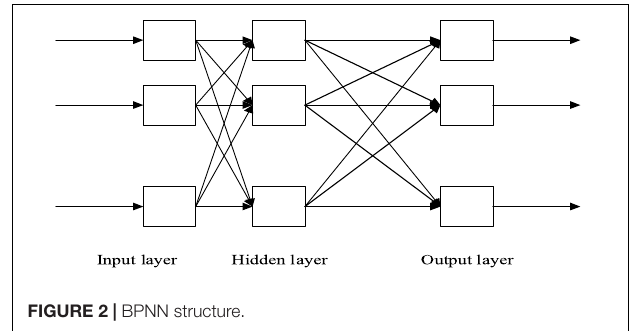
FIGURE 2 | BPNN structure.